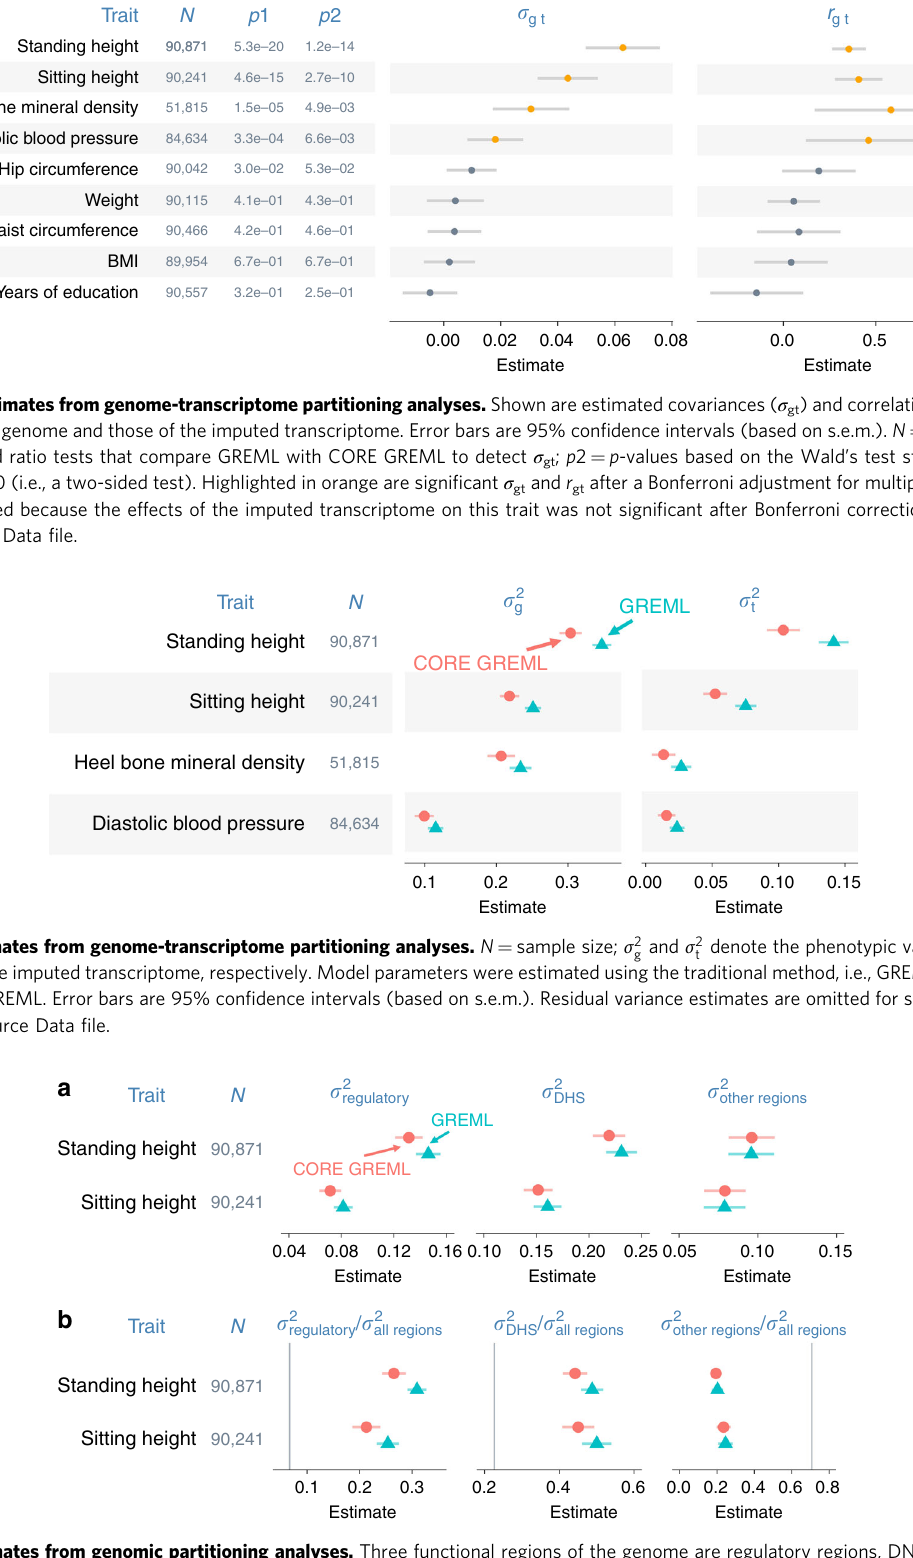
Fig. 6 Variance estimates from genomic partitioning analyses. Three functional regions of the genome are regulatory regions, DNase I hypersensitivity sites (DHS), and all other regions. N = sample size; σ 2 , σ 2 , and σ 2 denote phenotypic variances explained by the three functional regions. DHS regulatory otherregions Model parameters were estimated using the traditional method, i.e., GREML, and the proposed method, i.e., CORE GREML. a Variance-component estimates. b Estimated proportions of total genetic variance attributable to three functional regions of the genome. Error bars are 95% con fi dence intervals (based on s.e.m.). Vertical lines in b are percentages of SNPs from the three functional regions; conceptually, they are expected proportions of total genetic variance explained by the three functional regions of the genome assuming all genome-wide SNPs have an equal contribution to phenotypic variation. Residual variance estimates are omitted for simplicity. Source data are provided as a Source Data fi